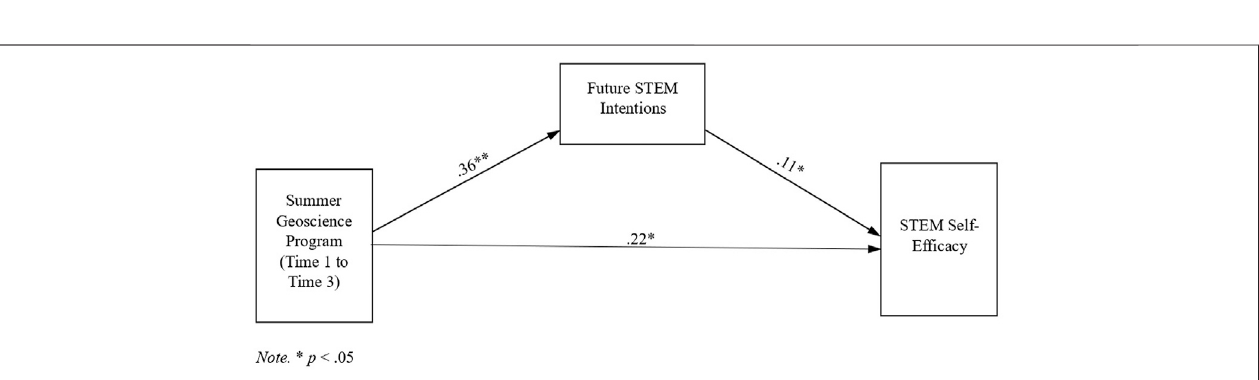
FIGURE 3 | Statistical model depicting effects of the summer geoscience program on STEM self-ef fi cacy, mediated by future STEM intentions.